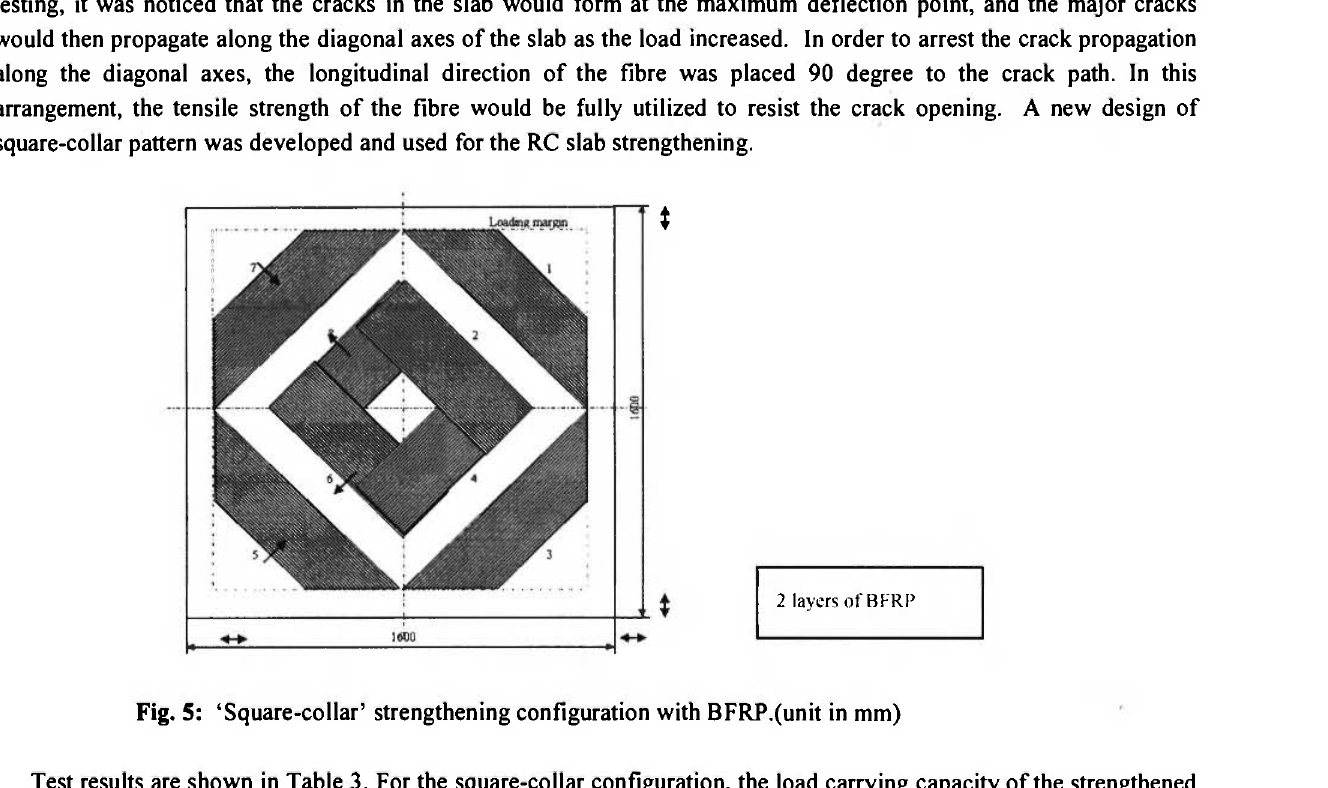
Fig. 5: 'Square-collar' strengthening configuration with BFRP.(unit in mm)